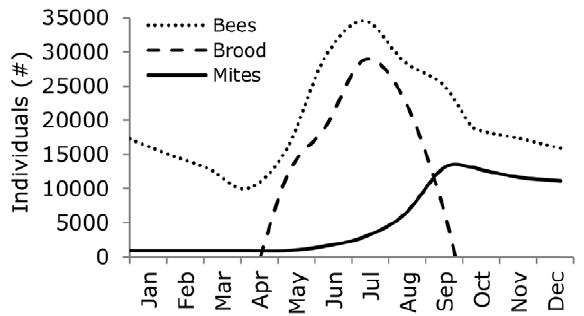
Figure 2. Expected infestation levels of Varroa destructor manipulated using acaricide treatment. Infestation levels of V. destructor (mites/bee) were manipulated using acaricide treatment applied at different moments (July, August, September or not treated at all). For the expected mite infestation, we used a simplified curve from mite infestation in Figure 1, with an exponential increase in mite infestation until October, after which the infestation remained equal. Efficacy of the acaricide Thymovar (July, August, September) was assumed to be 90%, while efficacy of oxalic acid (December) was assumed to be